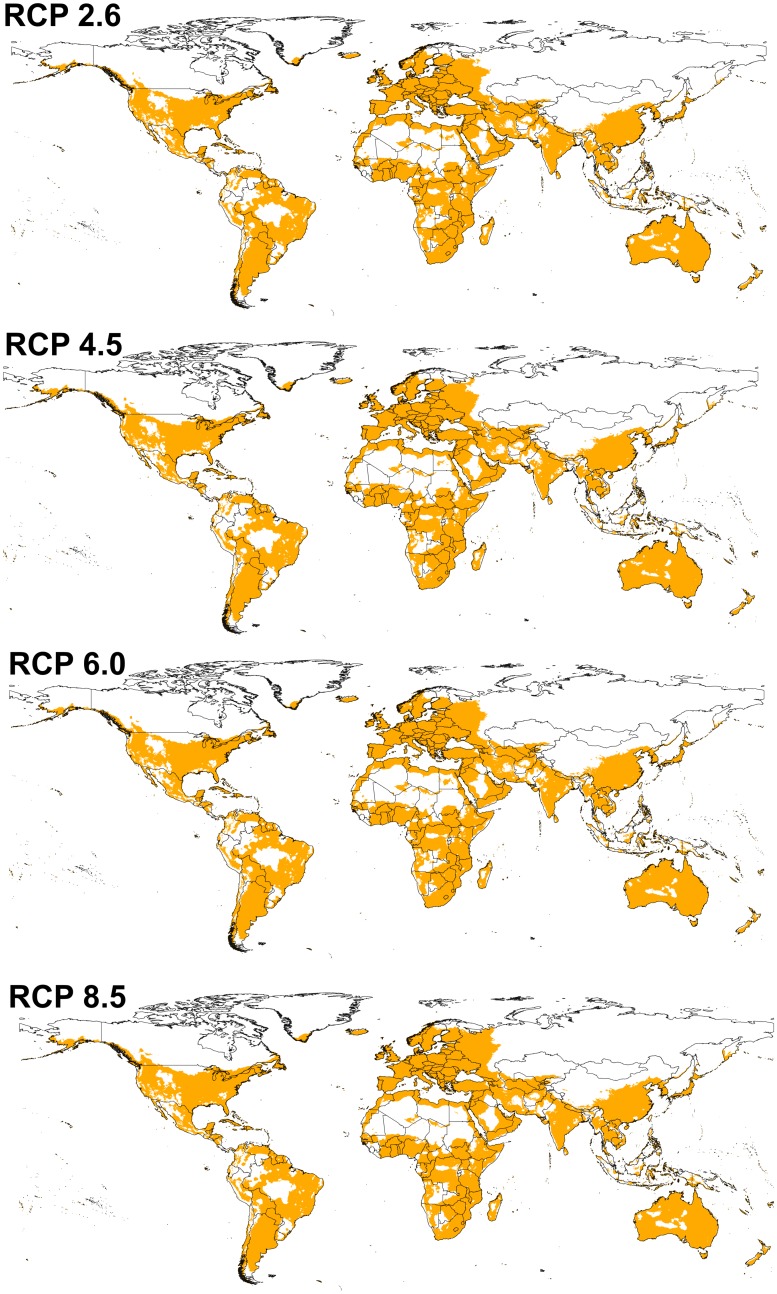
Predicted potential distribution maps for bluetongue virus under future climatic conditions.Models were calibrated across present-day conditions, and transferred to the future climate conditions. Each model is the median of all climate models across each representative concentration pathways (RCPs). Orange areas are modeled suitable conditions; white areas are unsuitable conditions for BTV occurrences.